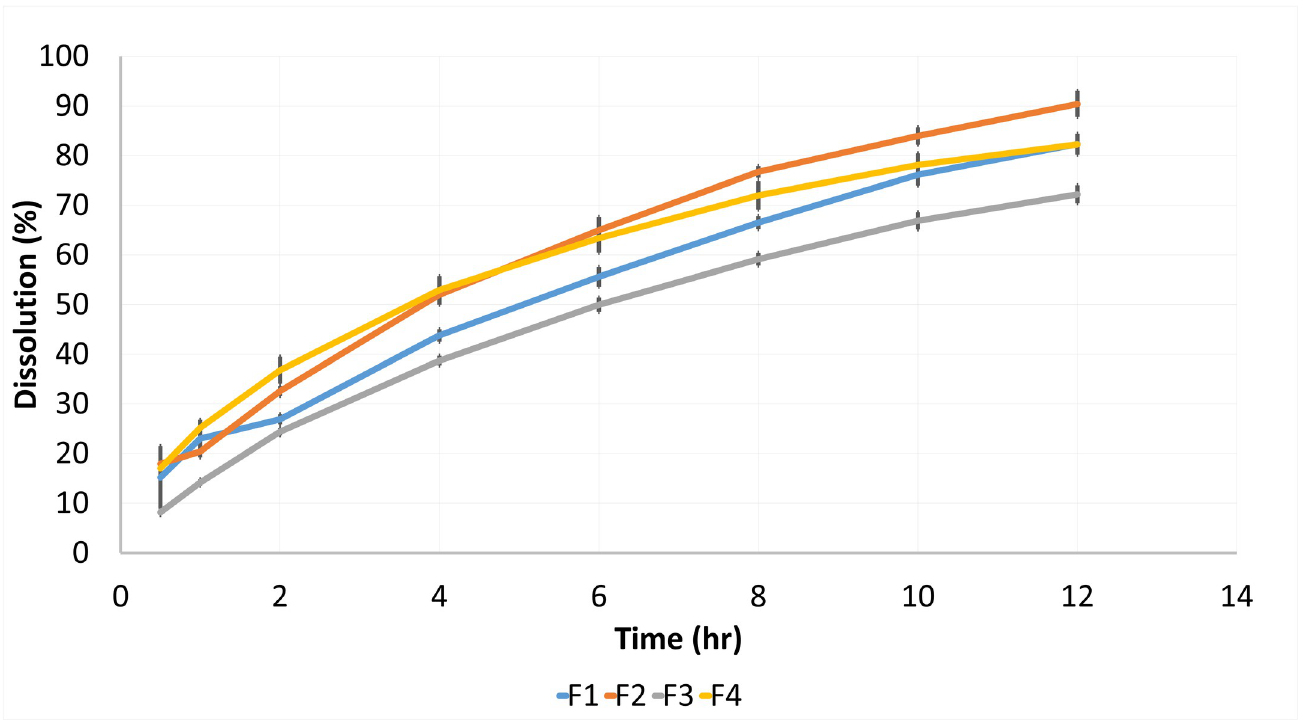
Fig 3. Cumulative percent drug release of trial formulations of propranolol HCl.